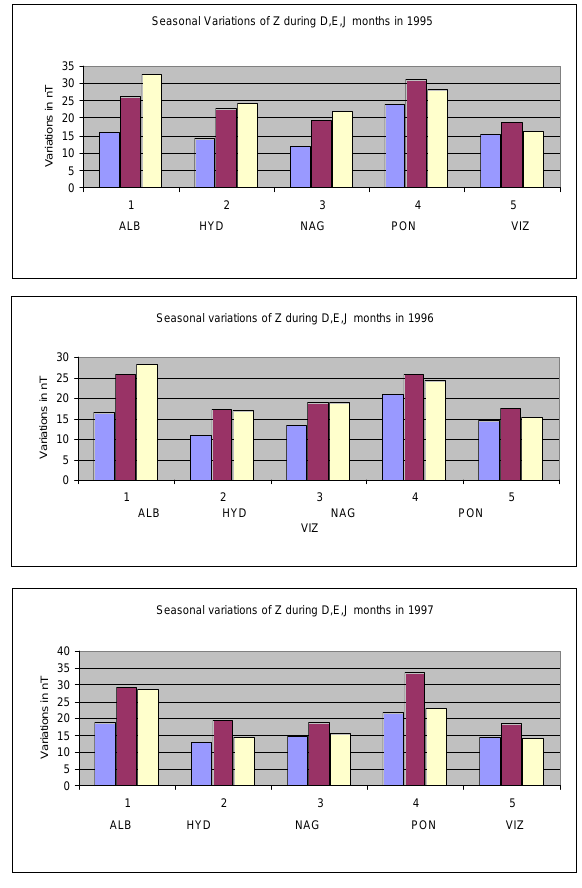
Fig. 3. Seasonal variations of the vertical Z-component during D, E, J